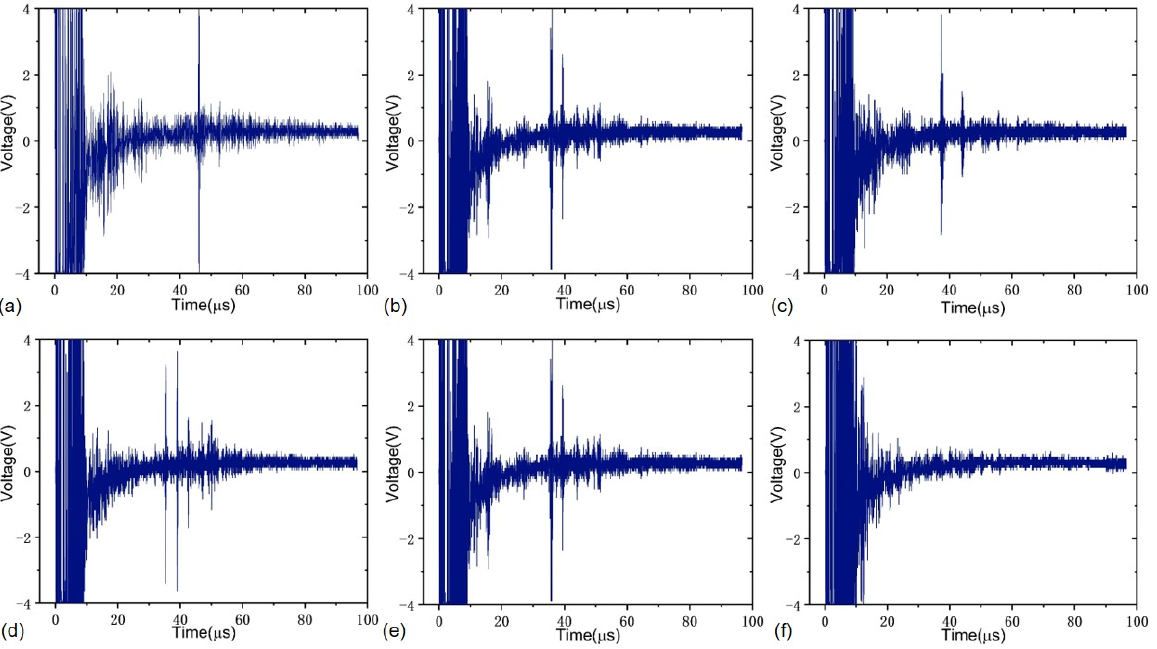
Figure 12. Received original ultrasonic echo signals for five different girth weld defects and defect- free case: ( a ) gas pores, ( b ) incomplete penetration, ( c ) cracks, ( d ) incomplete fusion, ( e ) slag inclusion, ( f ) no defect.